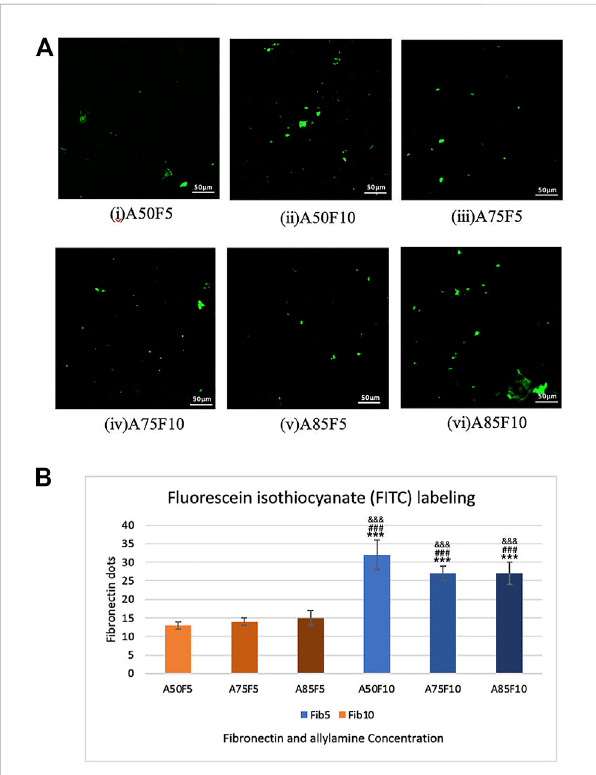
FIGURE 6 FibronectinconcentrationanalysisbyFIFClabellingimagesin (A) , (i) A50F5, (ii) A50F10. (iii) A75F5. (iv) A75F10, (v) A85F5 and (vi) A85F10 and (B) Analysis revealed that the number of fi bronectin dots increased with the concentration of fi bronectin solution when comparedwithA50F5indicatedwith*, p < 0.05,**, p < 0.005,and***, p < 0.001, while # symbol for comparing with A75F5 and, & symbol is applied for comparing with